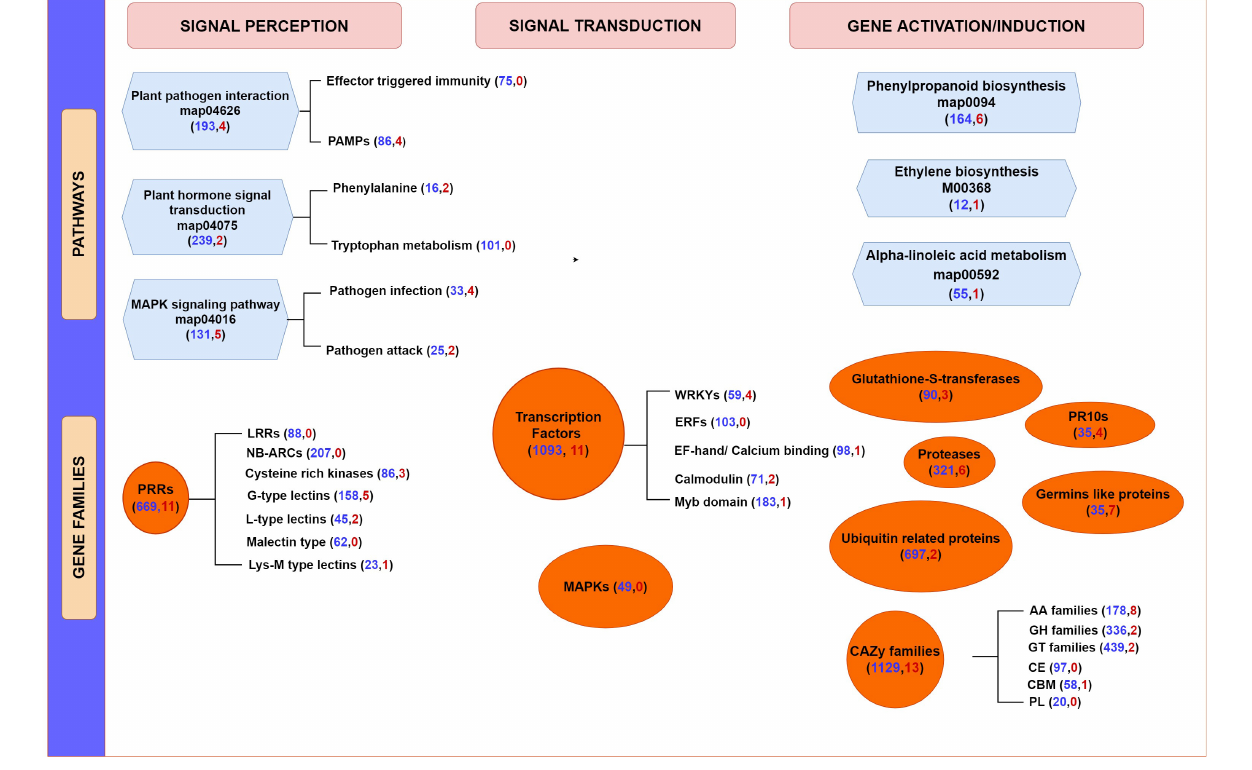
FIGURE 9 | A summary of T. cacao defense gene expression in immature leaves of three genotypes (ICS1/CCN51/Pound7) 24 h after infection by Phytophthora palmivora . Figure group genes based on their potential participation in specific KEGG gene pathways and different gene families. Genes are further separated based on their perceived participation in signal perception, signal transduction, or gene induction/activation. Numbers in parentheses indicate the total number of genes expressed in the cacao transcriptome (blue) and a total number of genes induced in all three genotypes (red), respectively. PAMPs, pathogen associated molecular patterns; PRR, pathogen recognition receptors; LRR, leucine-rich repeat; NB-ARC, nucleotide-binding adaptor shared by APAF-1,R proteins and CED-4 domain; EF hand, elongation factor hand domain; LysM, lysine M motif; ERF, ethylene responsive factor; MAPK, mitogen-activated protein kinase; PR10s, pathogenesis-related proteins; CAZy, carbohydrate-active enzymes; AA, Auxiliary Activities; GH, Glycoside hydrolase; GT, glycosyl transferases; CE, carbohydrate esterases; CBM, carbohydrate-binding modules; PL, polysaccharide